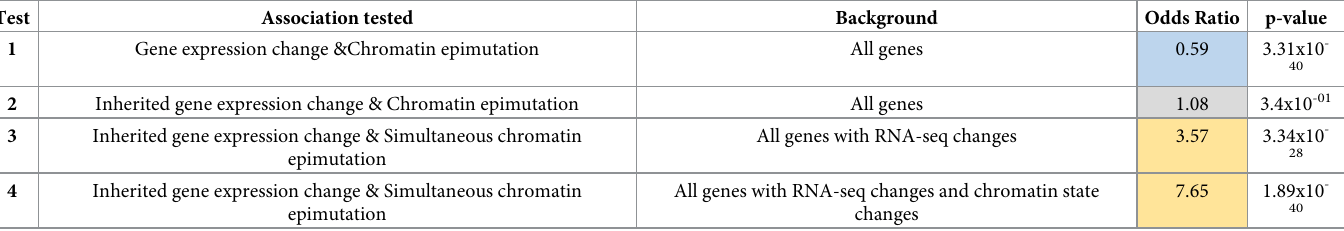
Table 1. Stepwise analysis of association of gene expression changes and chromatin-based epimutations. Cells in blue indicate significantly reduced odds of associa- tion, cells in grey indicate no significant association, cells in yellow indicate significantly increased odds of association. Odds ratios and p-values calculated with Fisher’s Exact Test.